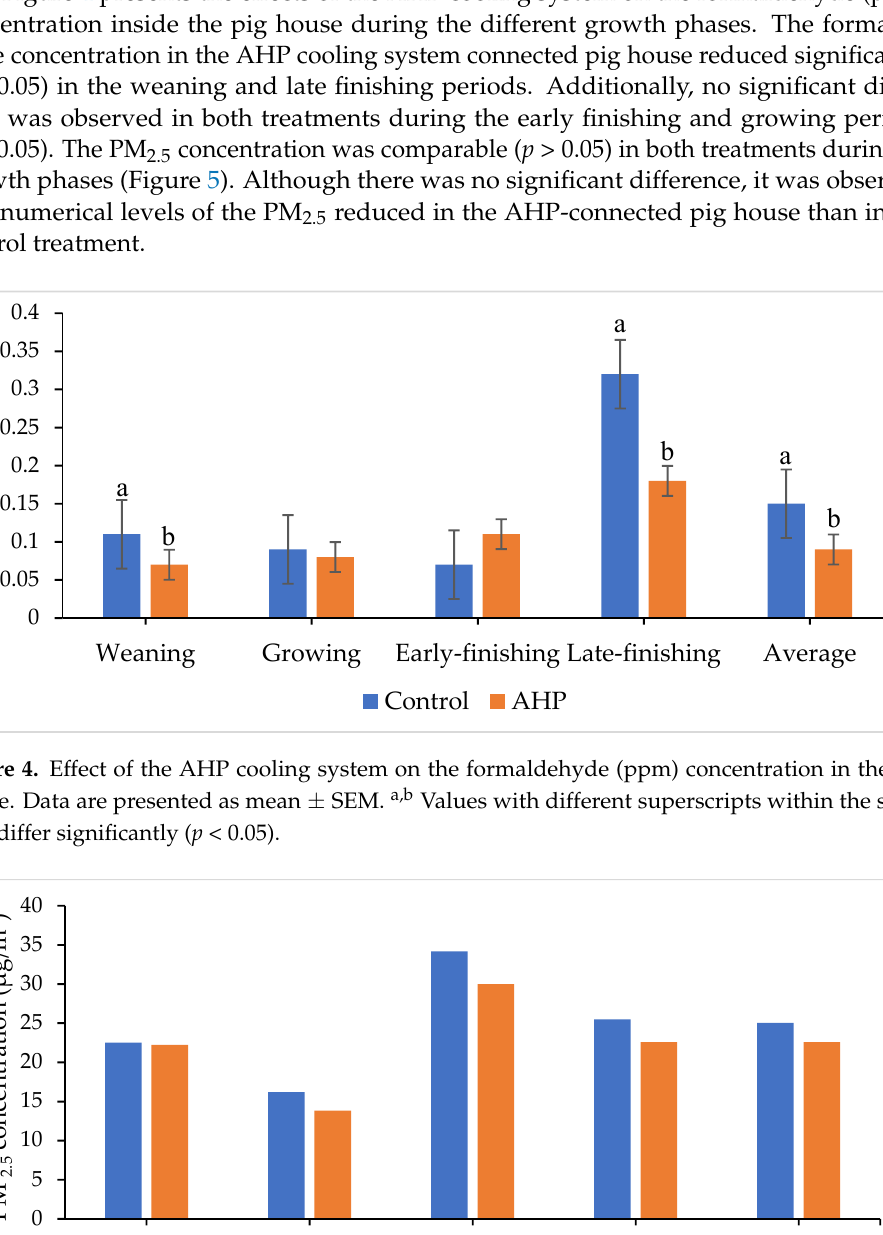
Table 4. Effects of the AHP cooling system on the energy utilization (kWh) and CO 2 emissions (kg) in the pig house.